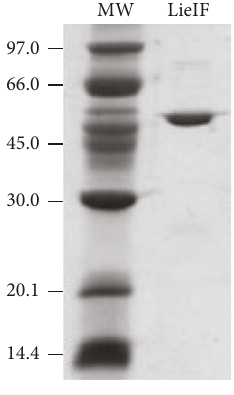
Figure 1: Expression and puri fi cation of the recombinant LieIF protein. Aliquots of puri fi ed protein were resolved by SDS-PAGE gel and stained with Coomassie Brilliant Blue. The positions of the Bio-Rad prestained markers (in kDa) are indicated at the